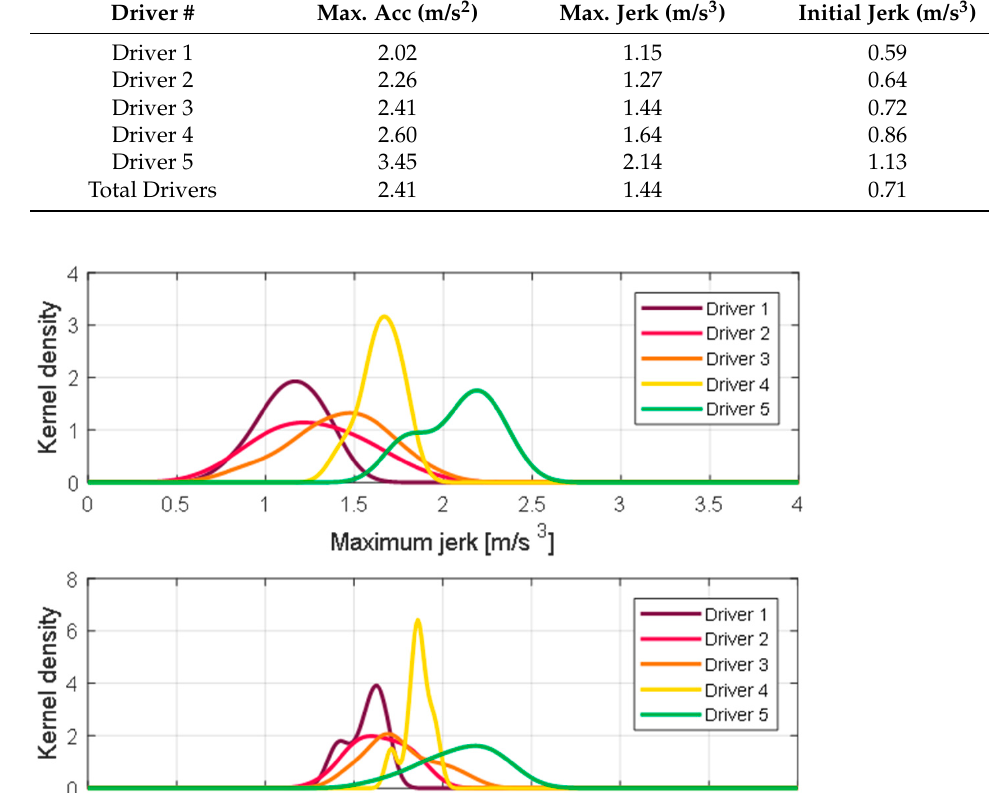
Figure 8. KDE of maximum jerk and initial jerk during the initial acceleration section.